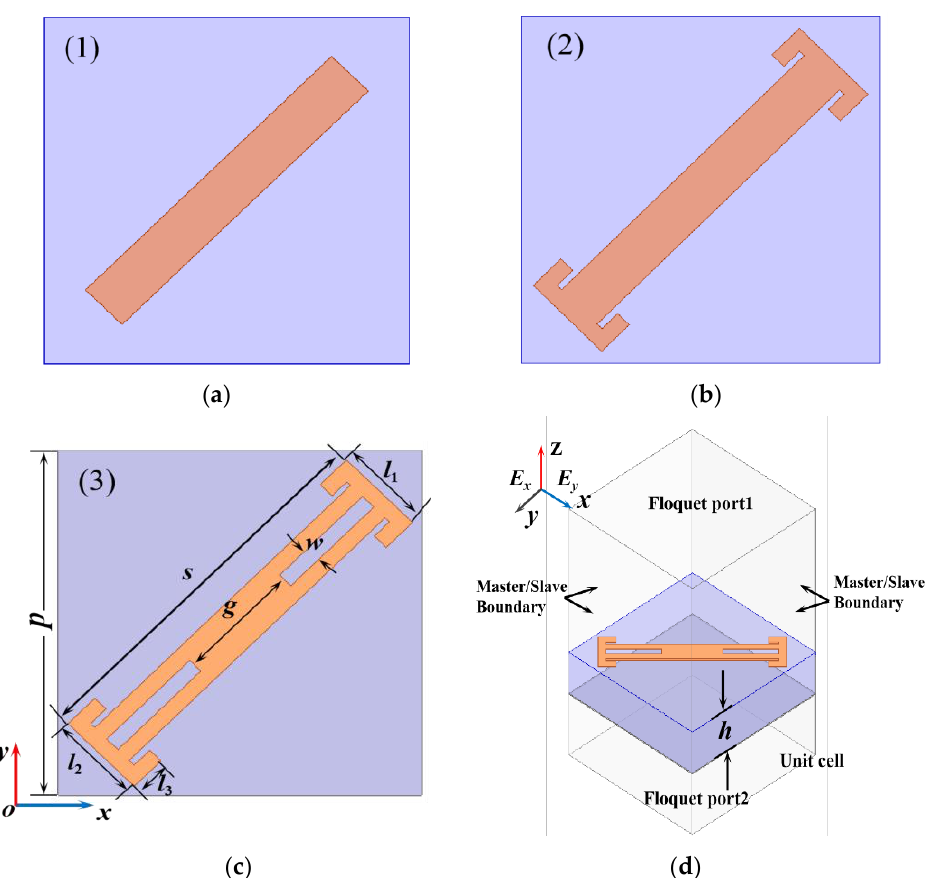
Figure 1. Evolution of the unit cell. ( a ) The slant dipole; ( b ) the end-loaded dipole; ( c ) the front view of the proposed polarization converter unit cell; ( d ) the schematic diagram of the port setting and boundary conditions for simulation.